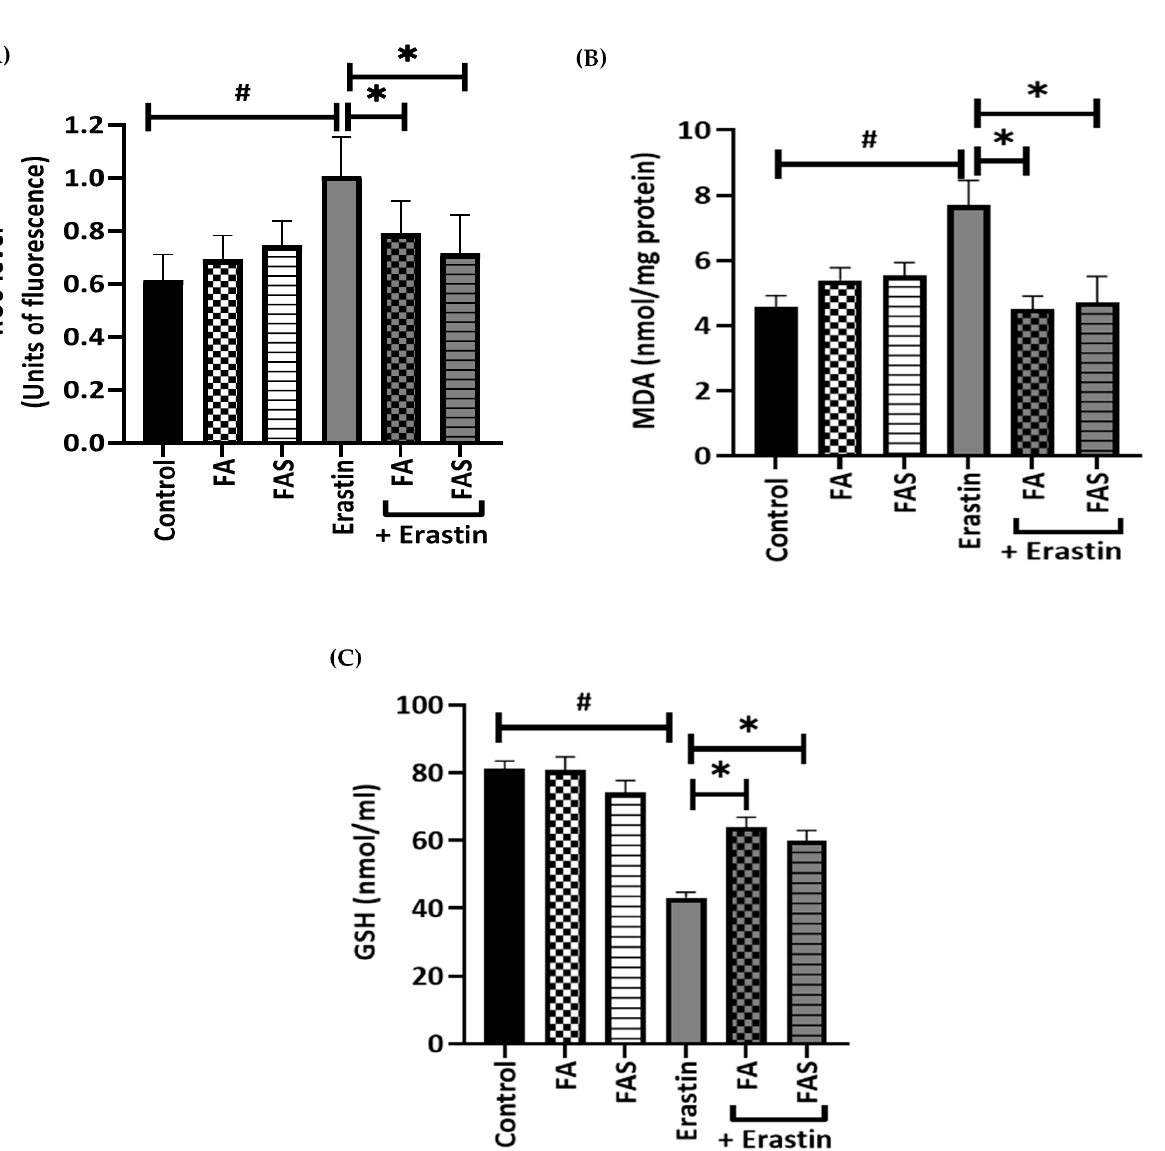
Figure 4. FA and FAS limit lipid peroxidation and ROS production by increasing GSH levels. Cells were treated with 20 µ M of erastin in the absence and presence of 20 µ M of ferulic acid (FA) or ferulic acid 4-O-sulfate disodium salt (FAS) for 24 h. Then, cellular reactive oxygen species (ROS) were estimated with a dihydrodichlorofluorescein (H2DCF) cell-permeant probe ( A ), lipid peroxidation levels were measured by malondialdehyde (MDA) assay ( B ), and glutathione (GSH) amounts were measured by total GSH assay ( C ). All the values are expressed as the mean ± SEM. # p < 0.05 control vs. treatment groups; * p < 0.05 erastin only vs. treatment groups. One-way ANOVA, Tukey’s post hoc test.